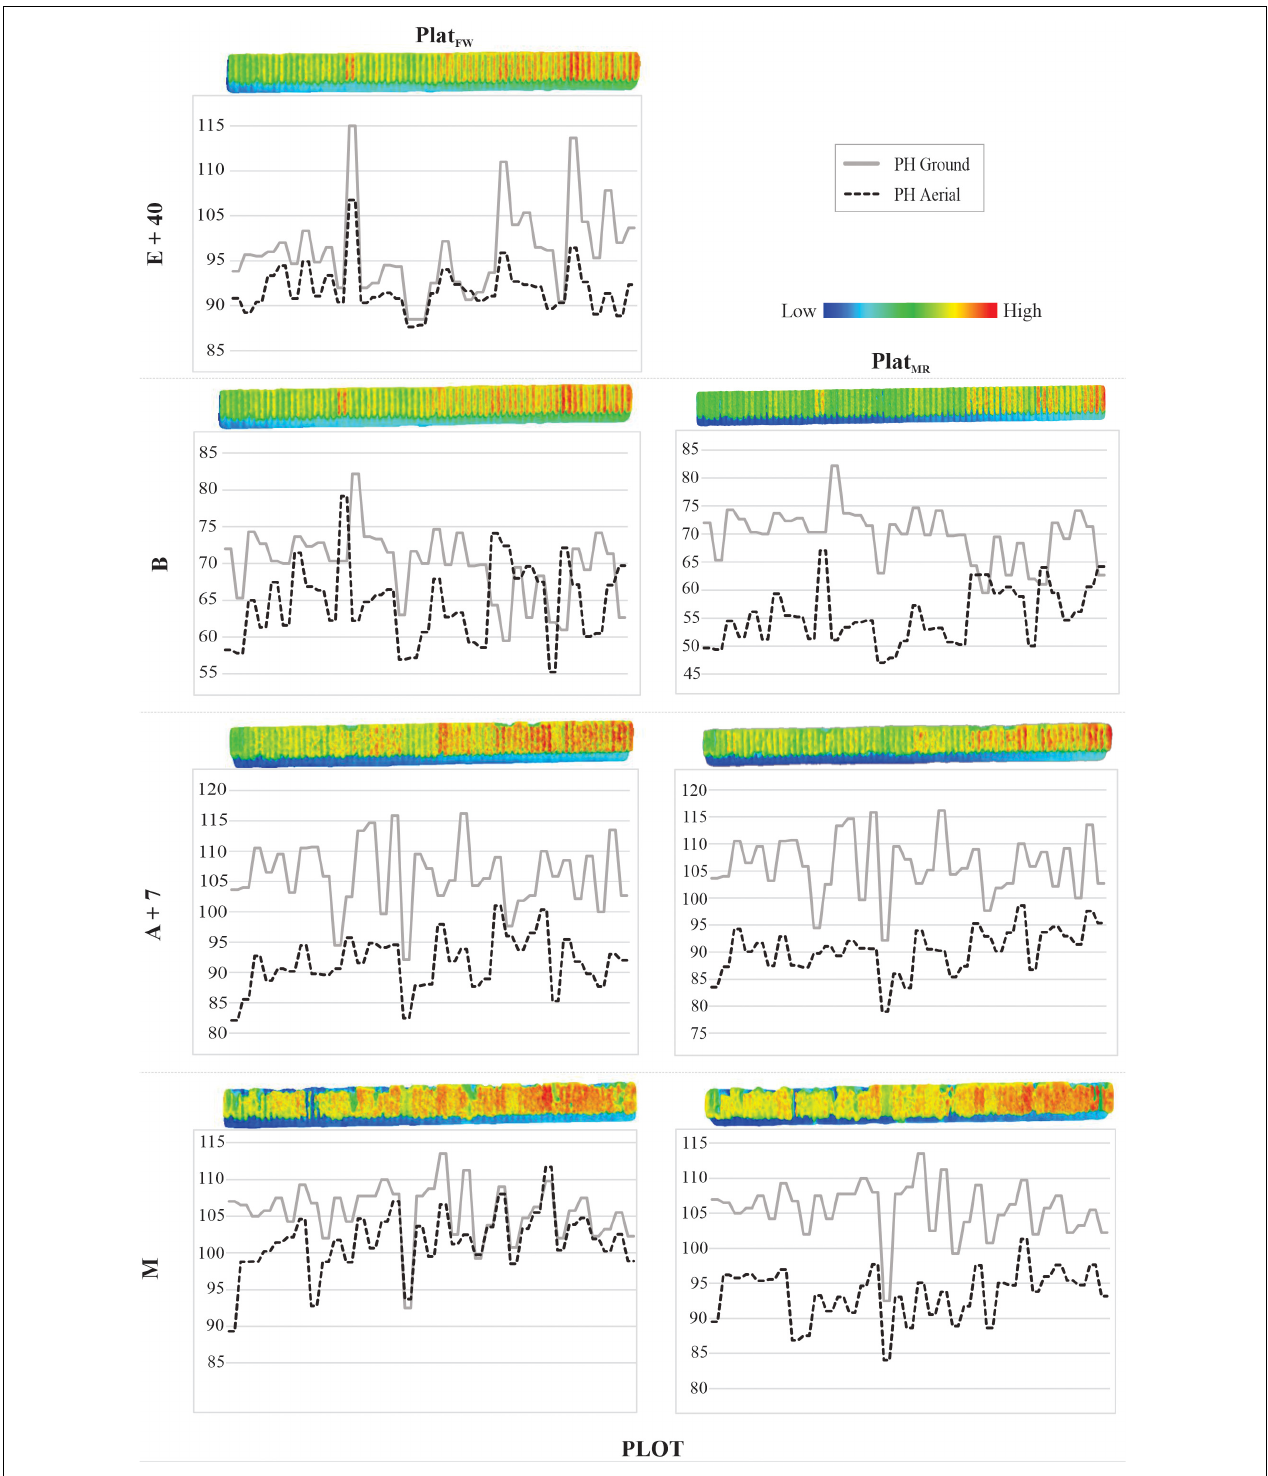
FIGURE 5 | Profile of 70 plots from HiBAP-II for Plat FW and Plat MR at the following growth stages (GS): 40 days after emergence (E+40), booting (B), 7 days after flowering (A+7), and at physiological maturity (M). Plant height (PH, cm) via ground-truth (ground) and unmanned aerial vehicle (UAV) data (aerial) are represented in the solid and dotted lines, respectively, matching with low (blueish) and high (reddish) color scale to PH. The 2D plots profiles image were generated using the textured mesh feature via the densified point cloud of Pix4D processing.